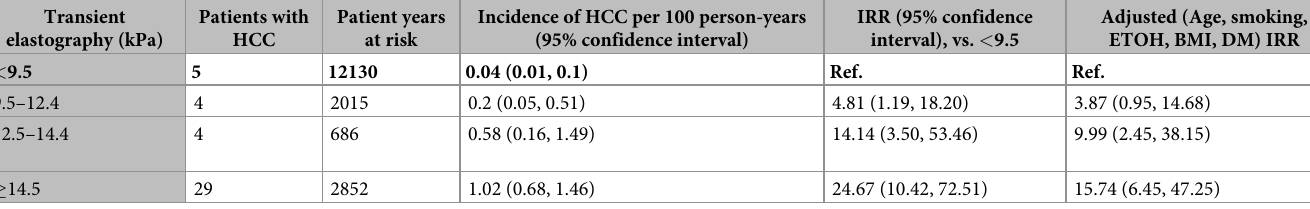
Table 3. Incidence of HCC in veteran population with NAFLD based on TE score. Transient elastography